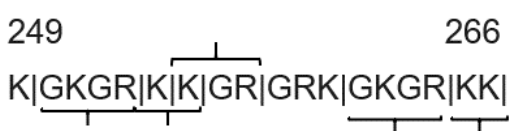
Figure 5. Amino acid sequence of the non-helical collagen alpha-3(V) region that contained multiple transglutaminase cross-links. Deduced trypsin cleavage sites are marked with vertical lines, and the sequences identified as cross-linked tryptic peptides by MassMatrix searches are marked with horizontal brackets.